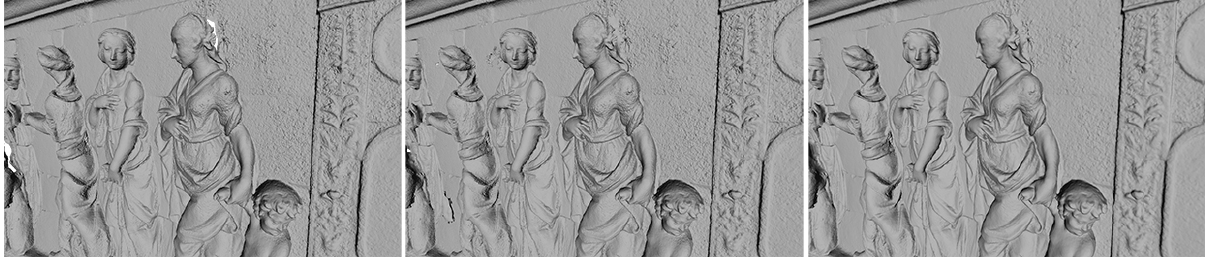
Figure 5. Comparison between meshing systems: (from left to right) model made using Photoscan, Meshlab (decimated after meshing), and Meshlab (decimated before